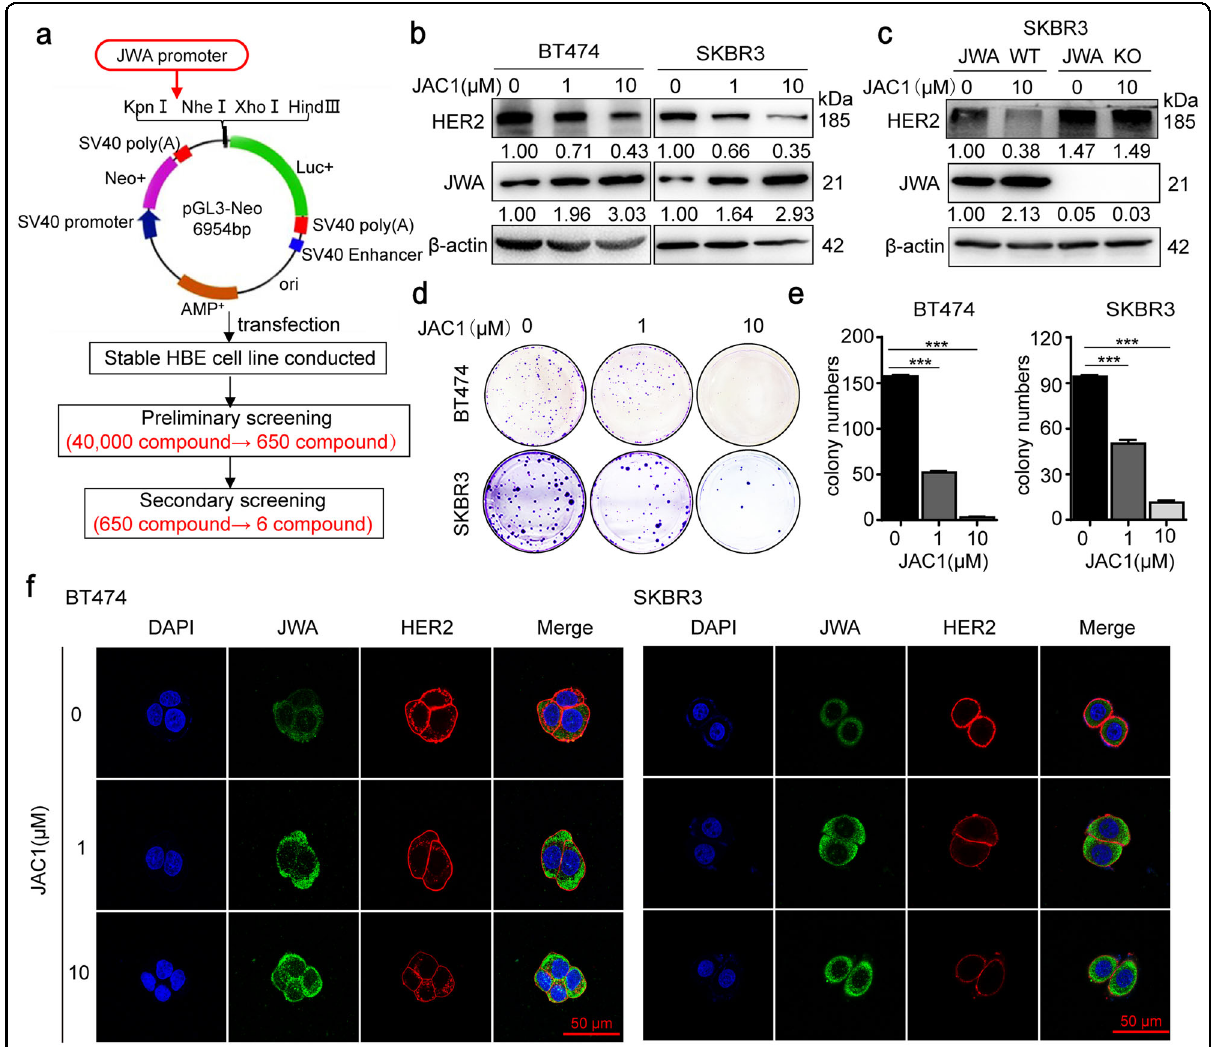
Fig. 2 JAC1 downregulates HER2 expression and inhibits cell proliferation in breast cancer. a Flow chart of a screening strategy for small molecule compounds JWA gene agonist. Through a series of high-throughput screening analyses of 40,000 compounds in the national compound library (Shanghai, China), 650 compounds were obtained. At last, six compounds were identi fi ed to have the ability to activate JWA expression according to their molecular weights, lipid water partition coef fi cients, and chemical structures. b Protein expressions of the HER2 and JWA were determined by western blot. c JWA/wild-type or JWA/KO cells were treated with JAC1 (10 μ M) for 24 h. HER2 and JWA protein expressions were determined by western blot. d , e Representative images of the colony formation assay for BT474 and SKBR3 cells after treatment with different concentrations of JAC1 (0, 1, 10 μ M). f BT474 and SKBR3 cells were treated with JAC1 (0, 1, 10 μ M) for 24 h, immuno fl uorescence imaging showed expressions of JWA (green), HER2 (red), nucleus (blue), the co-localization of the three signals